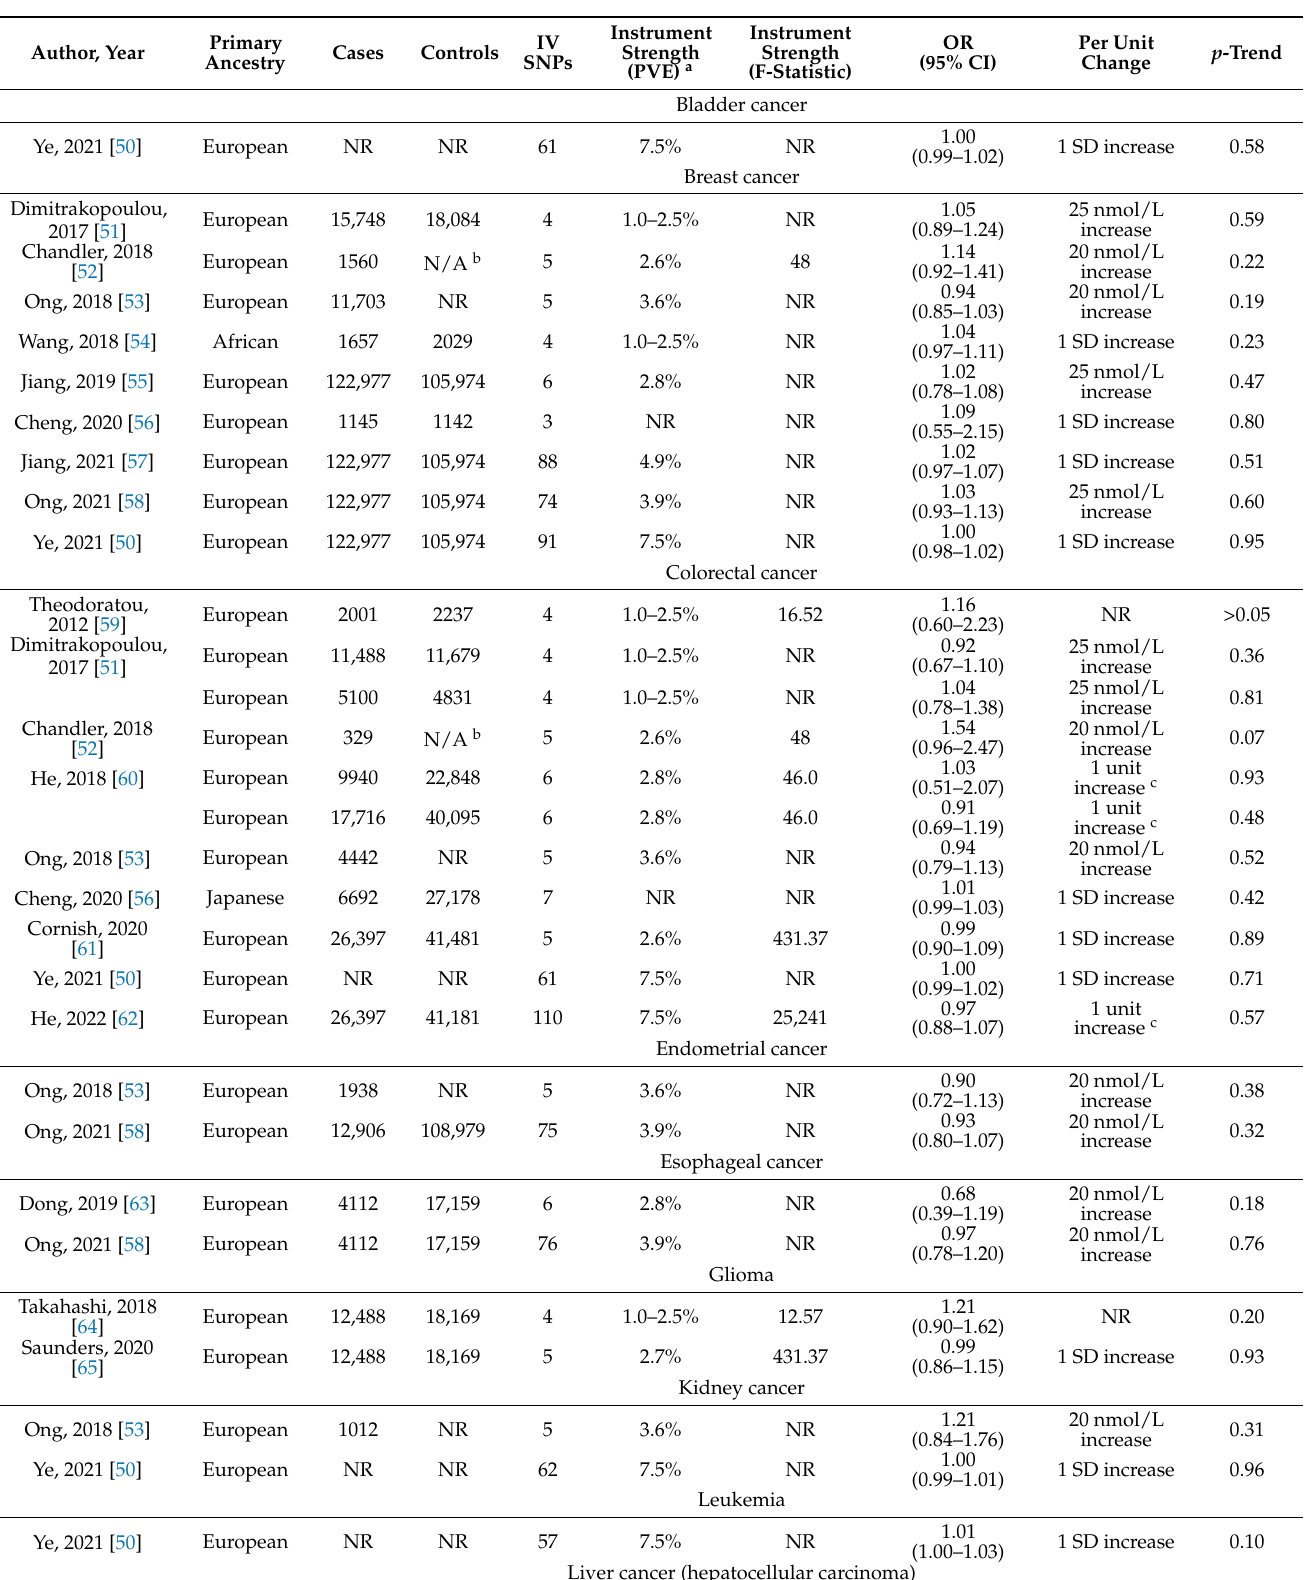
Table 1. Summary of all published Mendelian randomization (MR) estimates for the association between serum 25-hydroxyvitamin D and cancer outcomes. Additional study details are displayed in Supplementary Table